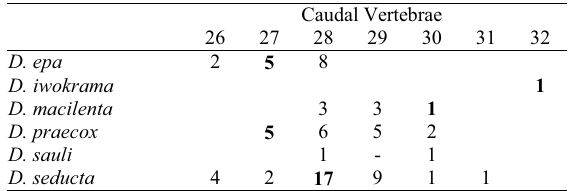
Table 22. Number of specimens of species of Denticetopsis with cited number of total vertebrae. Bold indicates value for holotype when examined. Value for D. royeroi , known only from holotype which could not be radiographed,